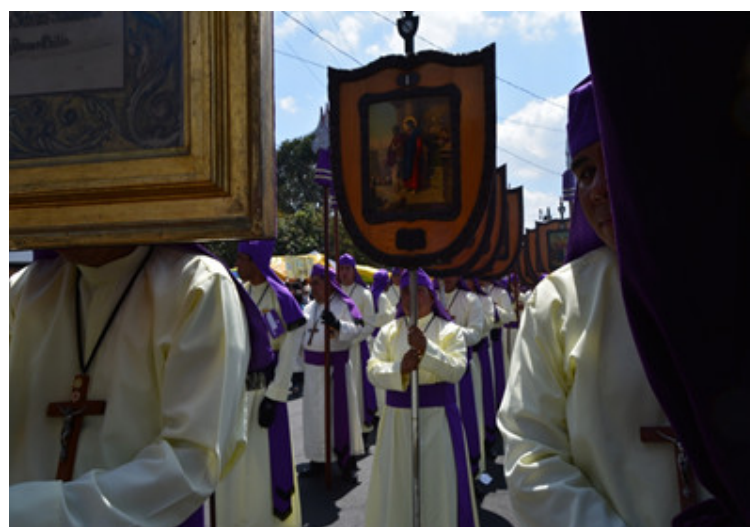
Figure 3. Cucuruchos in the procession before Palm Sunday, departing from the Temple of la Recoleccion. Photo: Karen Ponciano. Photo: Karen